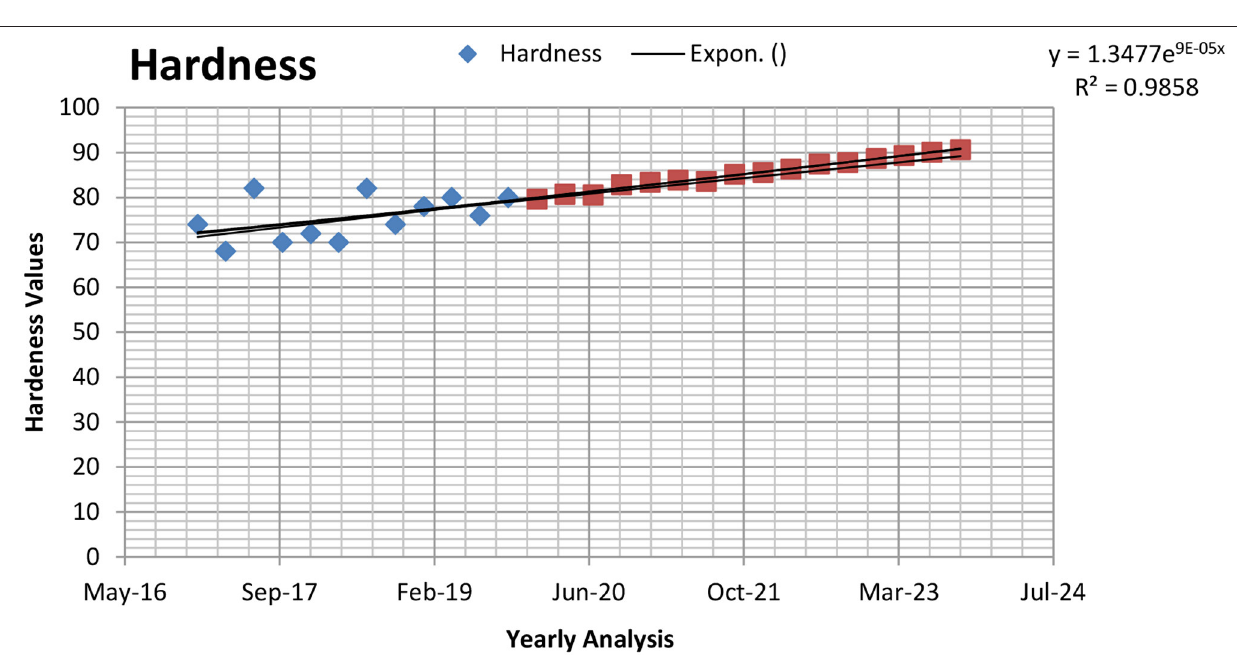
Frontiers in Environmental Science |